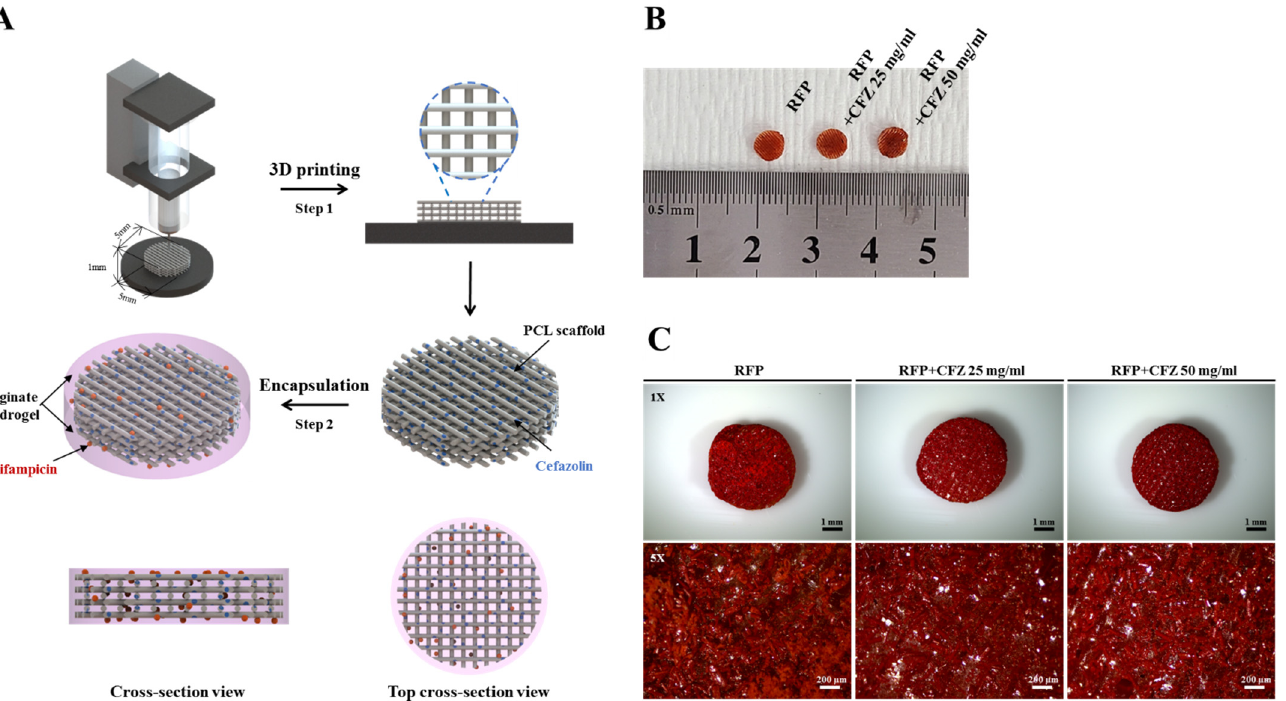
Figure 1. Fabrication procedure of the dual drug delivery systems: ( A ) 3D printing of a cefazolin– PCL scaffold to obtain a disk-shaped scaffold with 5 mm diameter and 1 mm thickness (step 1). Preparation of the cefazolin-loaded scaffold encapsulated in alginate mixed with rifampicin (step 2). ( B ) Gross view of the disk-shaped dual-drug scaffolds. ( C ) Microscope images showing the surfaces of rifampicin in the disk-shaped dual-drug scaffolds (1× bar = 1 mm; 4× bar = 200 μ m).